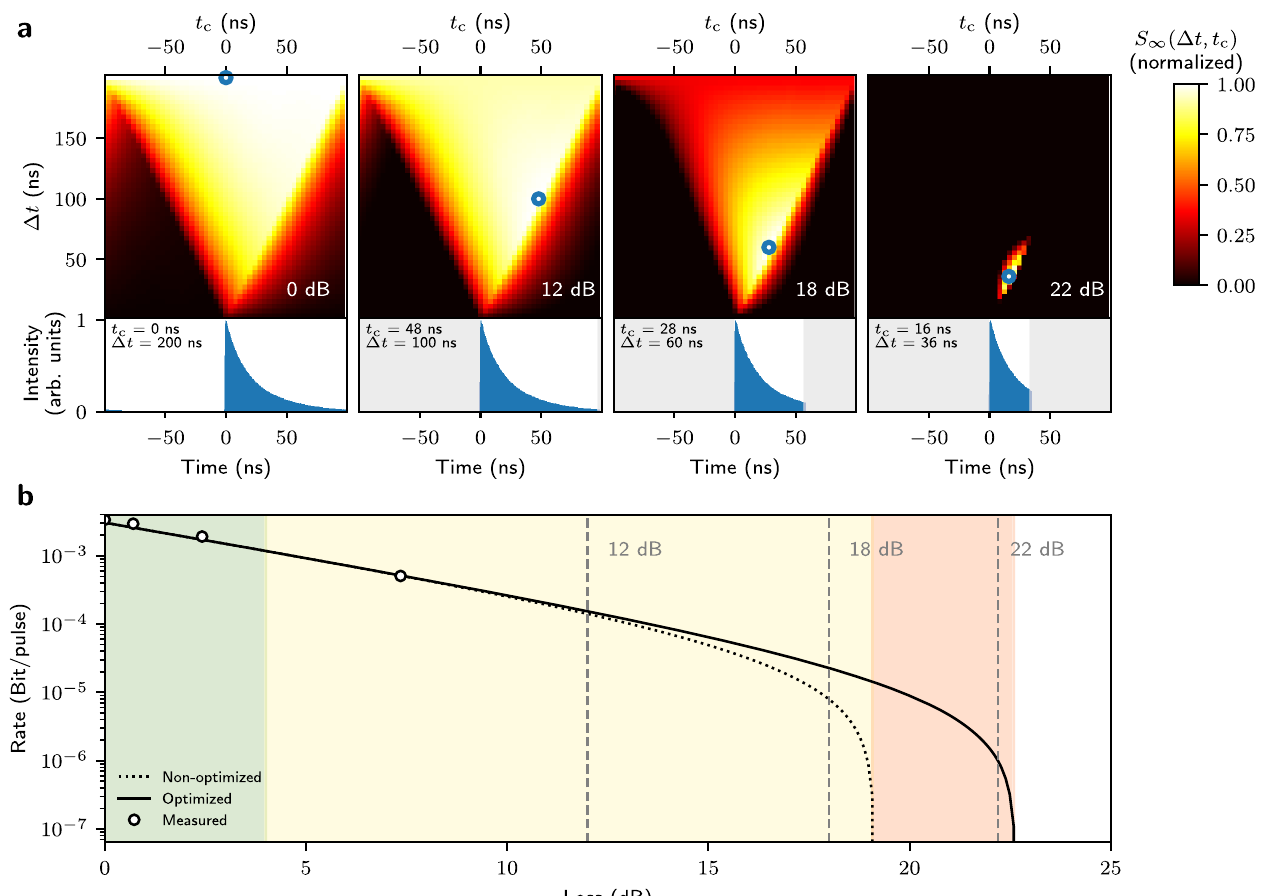
Fig. 3 Key rate optimization via 2D temporal fi ltering. a Expected secret key rate fraction S ∞ ( Δ t , t c ) as a function of the acceptance time window Δ t and t c . From the experimental results in back-to-back con fi guration (0 dB loss in the quantum channel) at 0.43 P sat and fi xed g (2) (0) = 0.134, three different loss scenarios are simulated. Blue circles mark the optimal parameter sets resulting in a maximal secret key rate. b Rate-loss diagram comparing the non-optimized secret key rate (compare Fig. 2c) and optimized case. For each individual loss, the secret key rate was optimized according to ( a ). Open circles correspond to experimental results using a variable attenuator in the quantum